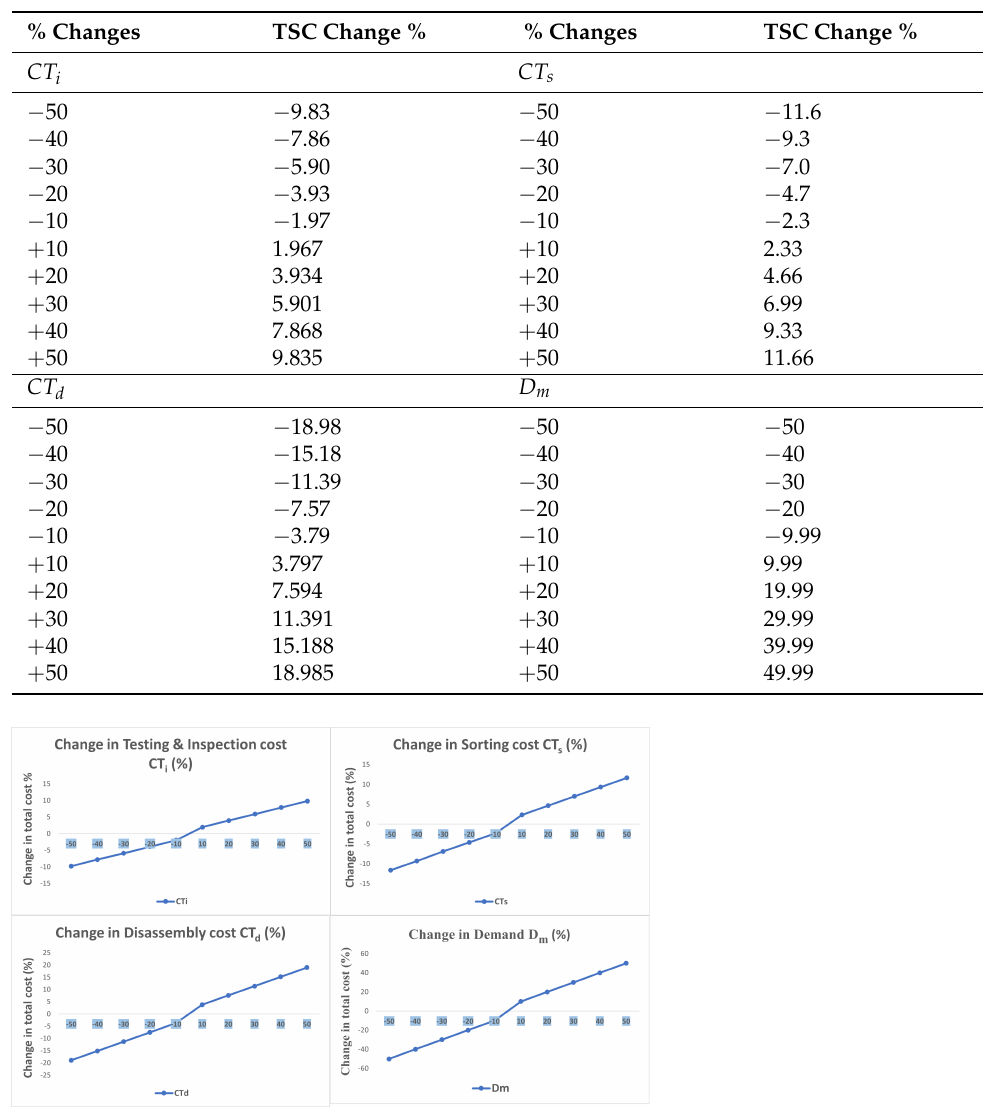
Figure 4. Sensitivity analysis of relevant